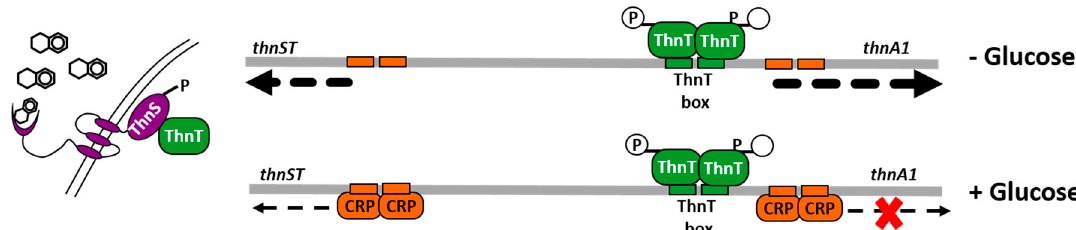
Figure 5. Elements involved in carbon catabolite repression in TFB. In the absence of glucose and presence of tetralin, phosphorylated ThnS transfer the P group to ThnT which binds the ThnT box and induces thnA1 transcription. In the presence of glucose, a CRP-like protein binds CRP-like binding sites present at thnS and thnA1 promoters provoking a reduction in thnS transcription and impeding thnA1 transcriptional activation by phosphorylated ThnT.